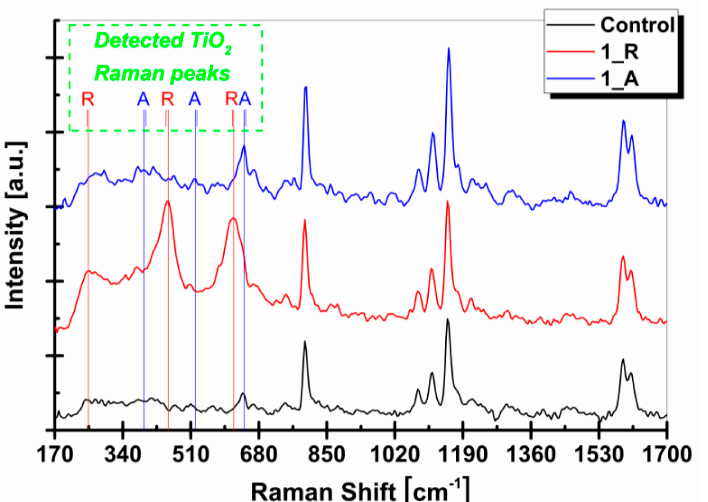
Figure 5. Raman spectra of membranes with 1 wt.% TiO 2 rutile and anatase nanoparticles and control membrane. Note: the vertical lines that intersect the graphic represent the detected wavenumbers of anatase and rutile peaks in the nanocomposite membrane; the short vertical lines represent the detected wavenumbers of anatase and rutile peaks in the nanopowders.